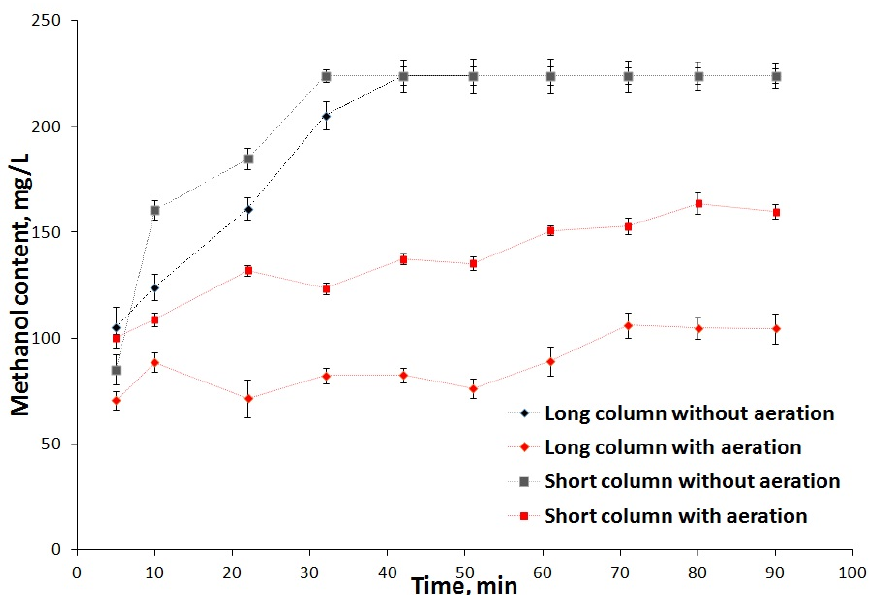
Figure 10. Dependence of methanol content at the outlet of the trickling biofilter column with a biocatalyst based on yeast encapsulated in STP EG -composite on the time of operation (standard deviation, n = 10).